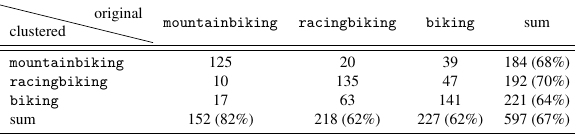
Table 1. Contingency table, showing the number of trajectories assigned by the user and by k-means clustering to biking , mountainbiking and racingbiking